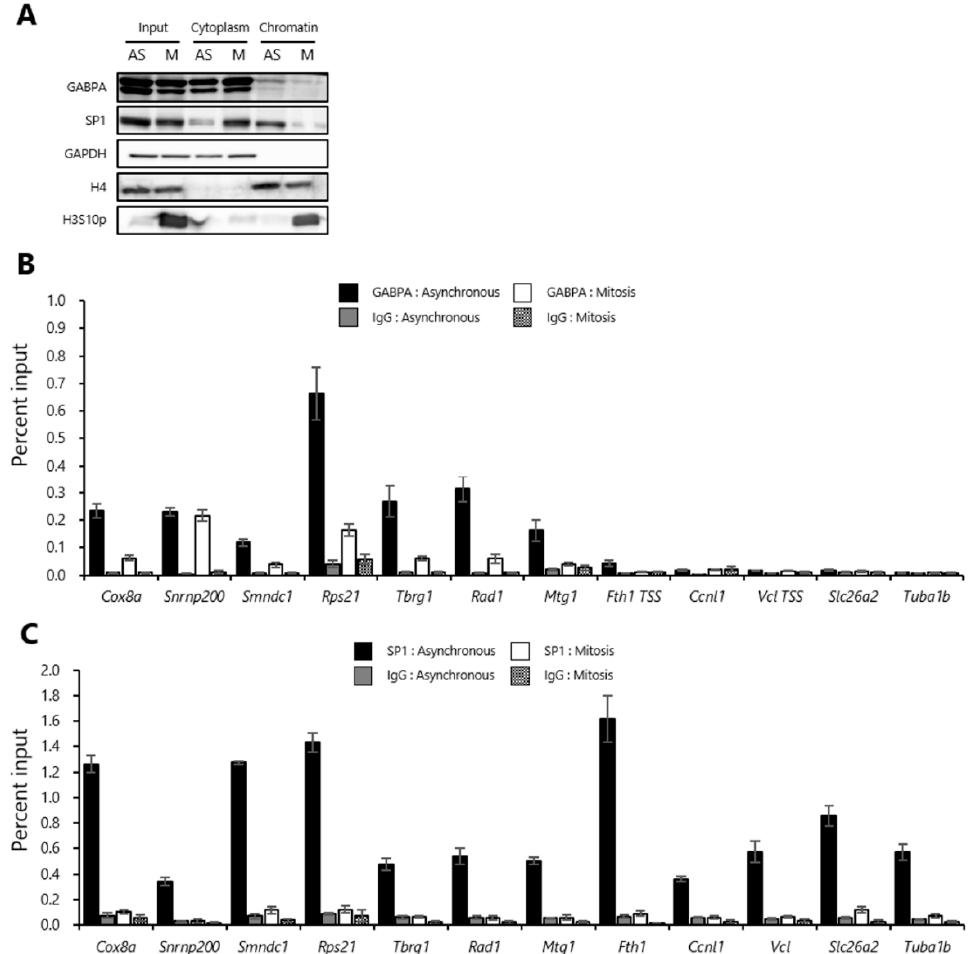
Figure 1. GA-binding protein transcription factor alpha subunit (GABPA), but not Sp1 transcription factor (SP1), partly binds to the analyzed genes in mitosis. ( A ) Protein levels of GABPA and SP1 in the cytoplasmic and chromatin fractions. Asynchronous (AS) and mitotic-arrested (M) tsFT210 cells were fractionated into cytoplasmic and chromatin fractions. The fractions were then analyzed by western blotting with the indicated antibodies. Glyceraldehyde-3-phosphate dehydrogenase (GAPDH) and histone H4 (H4) were used as controls for the cytoplasmic and chromatin fractions, respectively. Phosphorylation at Ser10 of histone H3 (H3S10p) is a marker of mitotic cells. ( B , C ) Bindings of GABPA and SP1 at the upstream regions of the genes reactivated during the M/G1 transition in asynchronous and mitotic-arrested tsFT210 cells. Asynchronous and mitotic-arrested tsFT210 cells were subjected to chromatin immunoprecipitation using antibodies against GABPA and SP1, followed by quantitative PCR using primer sets specific for the upstream regions of the several genes reactivated during the M/G1 transition. Normal rabbit IgG was used as a negative control. Error bars denote SEM ( n = 3).